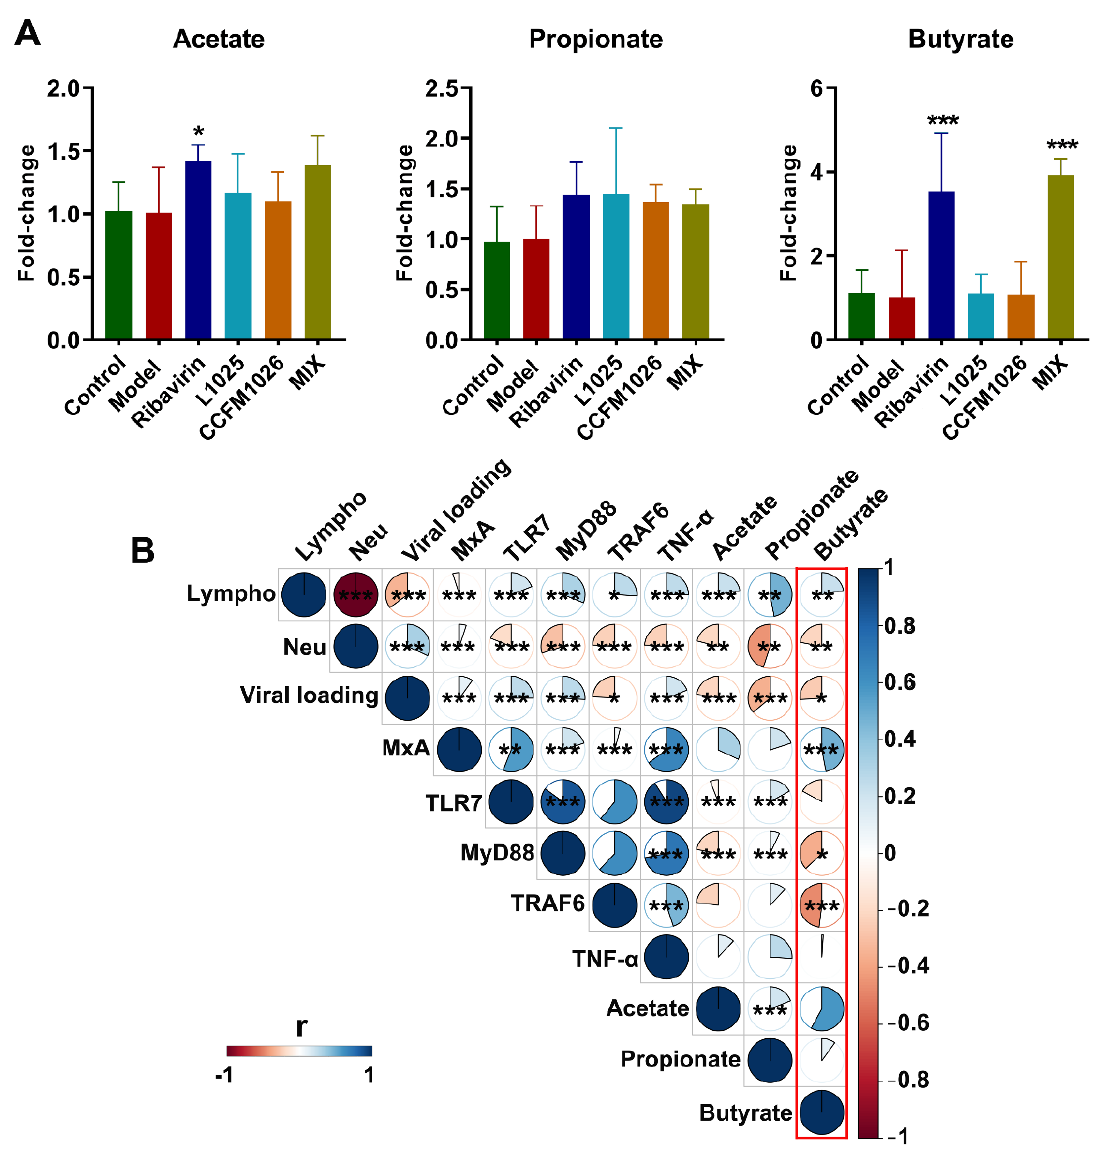
Figure 8. Short-chain fatty acids (SCFA) production and the correlation with disease indicators. ( A ) Fold-change in SCFA (the statistical difference was evaluated using one-way ANOVA and post hoc Fisher’s least significant difference (LSD) tests, *, *** vs. the model group). ( B ) The correlation between SCFA and disease indicators. * p < 0.05, ** p < 0.01 and *** p <